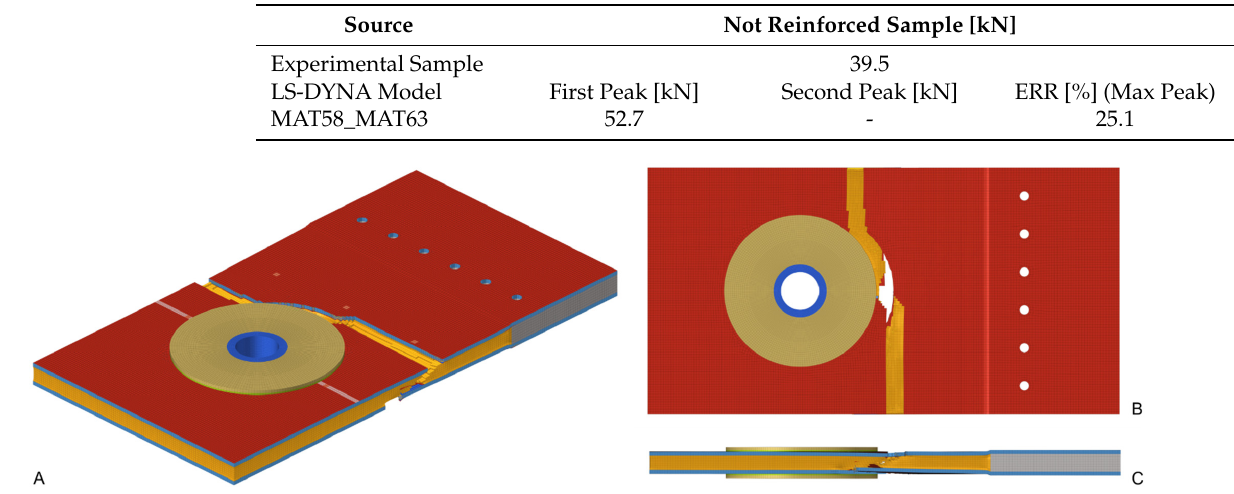
Table 9. Not reinforced maximum load comparison.